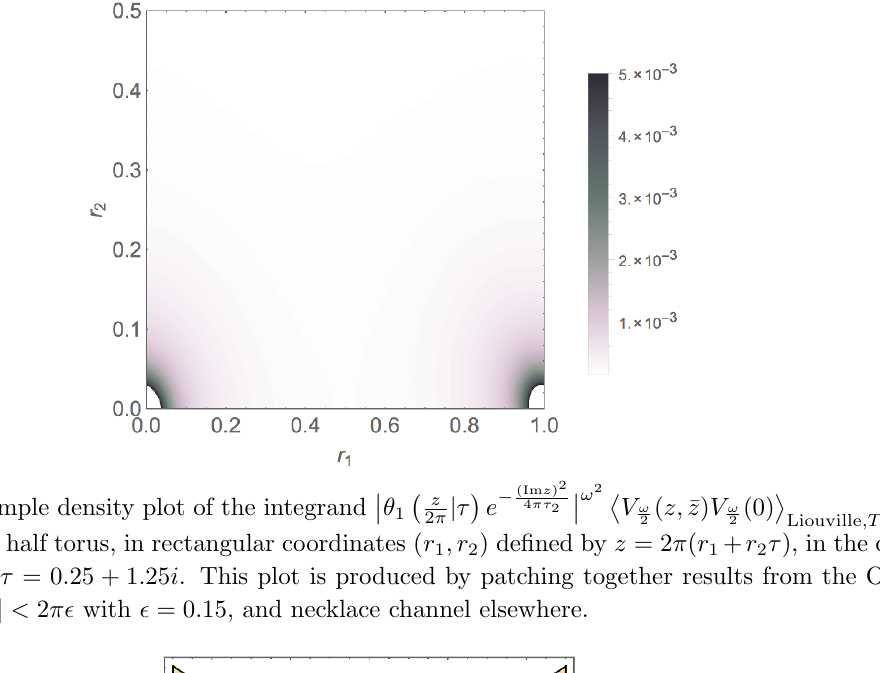
Figure 6 . Sample density plot of the integrand over the lower half torus, in rectangular coordinates ( r 1 ; r 2 ) de(cid:12)ned by z = 2 (cid:25) ( r 1 + r 2 (cid:28) ), in the case ! = 0 : 8 i and (cid:28) = 0 : 25 + 1 : 25 i . This plot is produced by patching together results from the OPE channel for j z j < 2 (cid:25)(cid:15) with (cid:15) = 0 : 15, and necklace channel elsewhere.